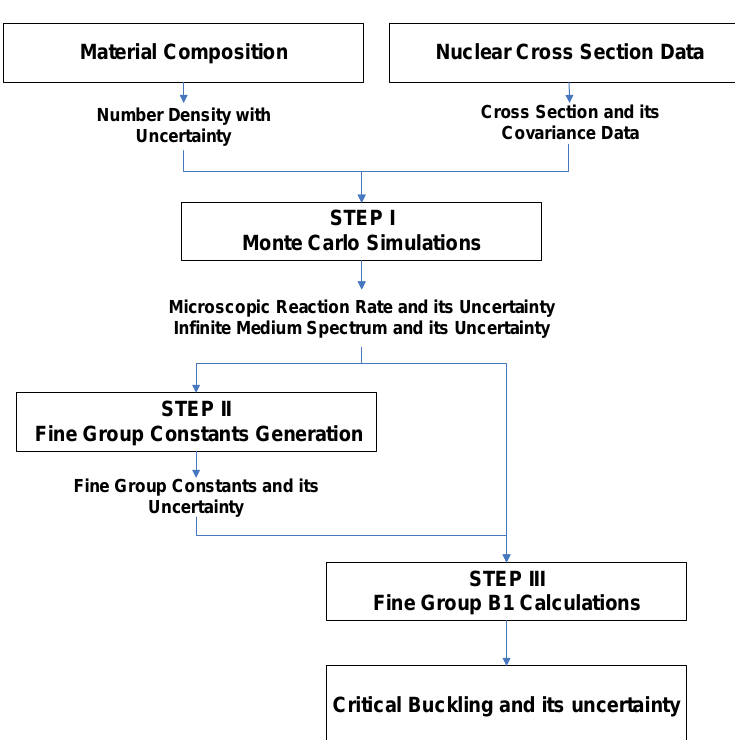
Figure 1. Flowchart of critical buckling generation using the B 1 theory-augmented MC method.